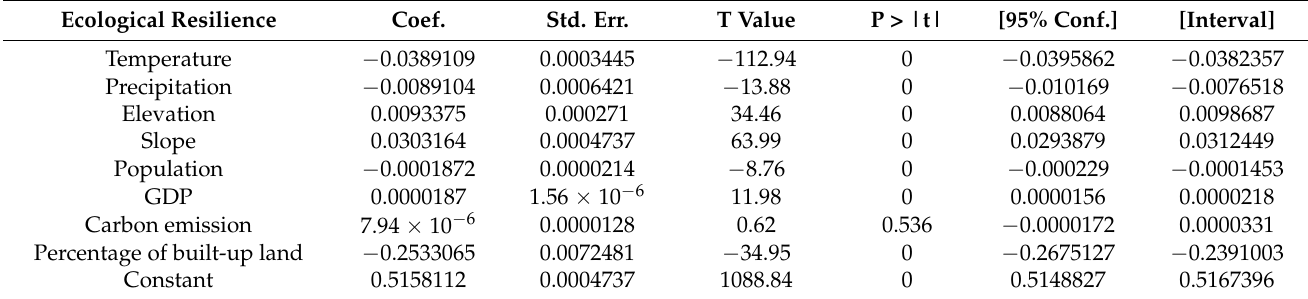
Table 2. Regression results of the resilience impact factor